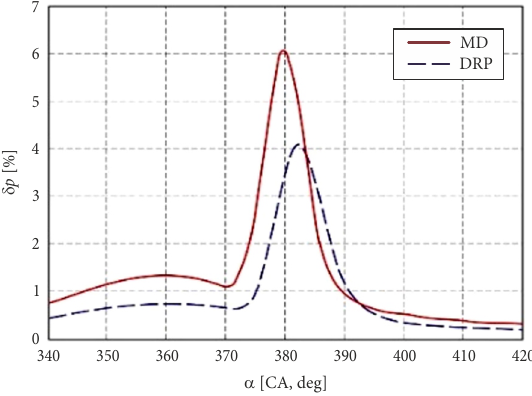
Figure 1. Mean cycle-by-cycle differences in cylinder pressure vs CA for MD and DRP (1500 rpm / 50 N ⋅ m)